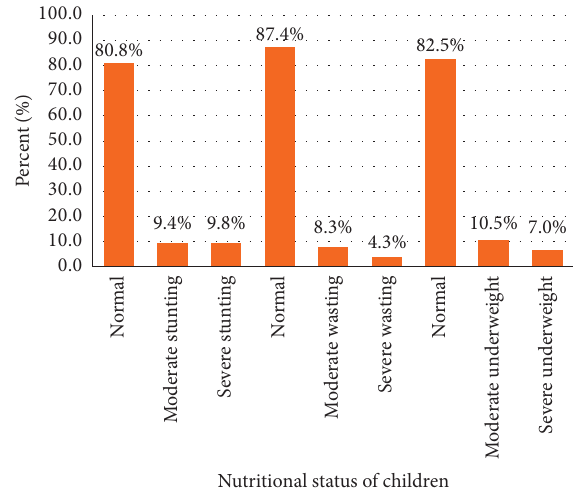
Figure 1: Nutritional status of children aged 6–23 months in Debre Berhan Town, North Shewa Zone, Ethiopia,